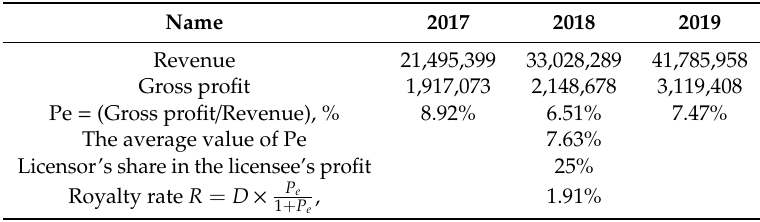
Table 6. The calculated royalty rate (annual